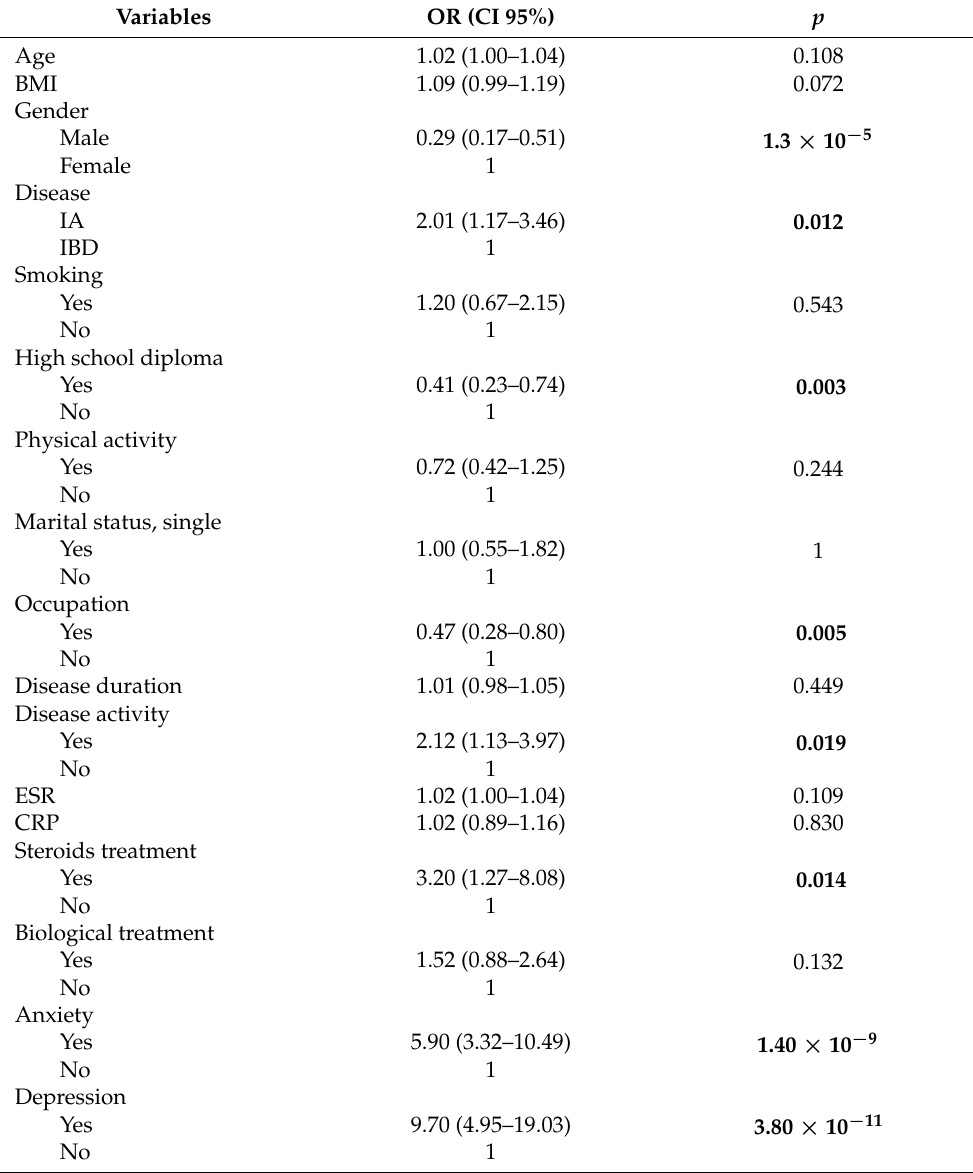
Table 2. Univariate logistic regression model for fatigue in